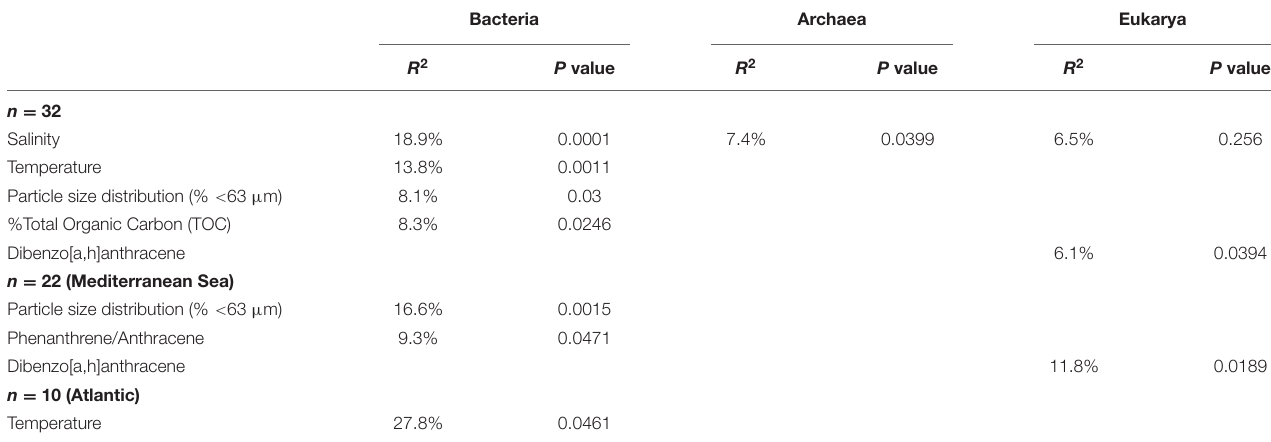
TABLE 1 | PerMANOVA results for environmental parameters against UNIFRAC matrices.